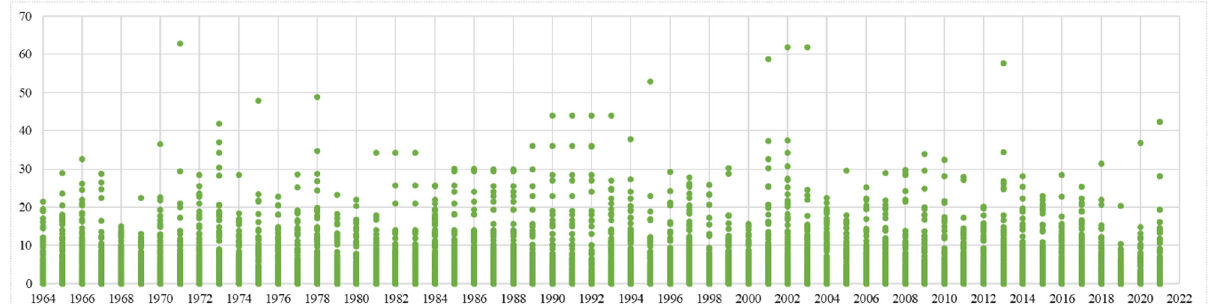
Figure 4: Average rainfall in the study area, between the years 1964 and 2021, obtained from SENAMHI - Puno meteorological